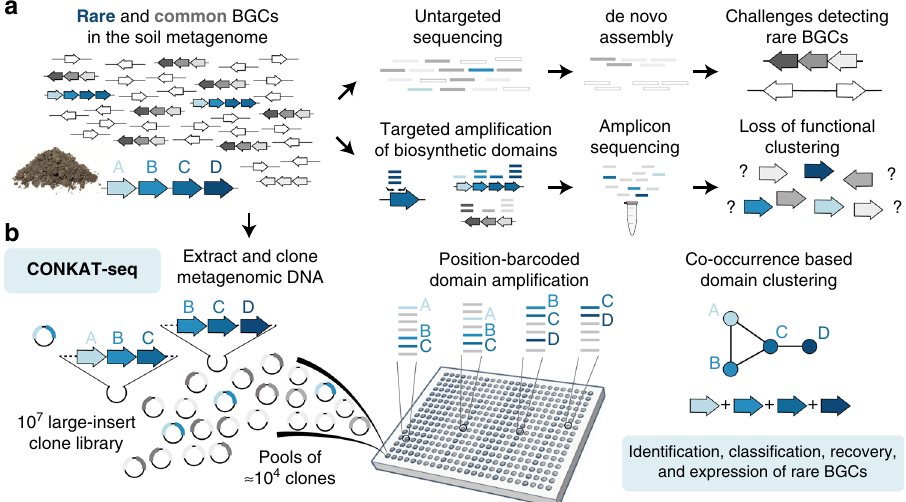
Fig. 1 CONKAT-seq enables the exploration of rare biosynthetic gene clusters in complex metagenomes. a Untargeted methods to explore the biosynthetic potential of low frequency organisms in the soil metagenome are limited by the required high coverage depth, and computationally challenging de novo assembly process. PCR based methods are extremely sensitive, but do not capture the functional clustering of biosynthetic domain and therefore are information poor. b CONKAT-seq uses the highly partitioned structure of metagenomic cosmid libraries to reconstruct the chromosomal organization of biosynthetic domains based on PCR amplicon